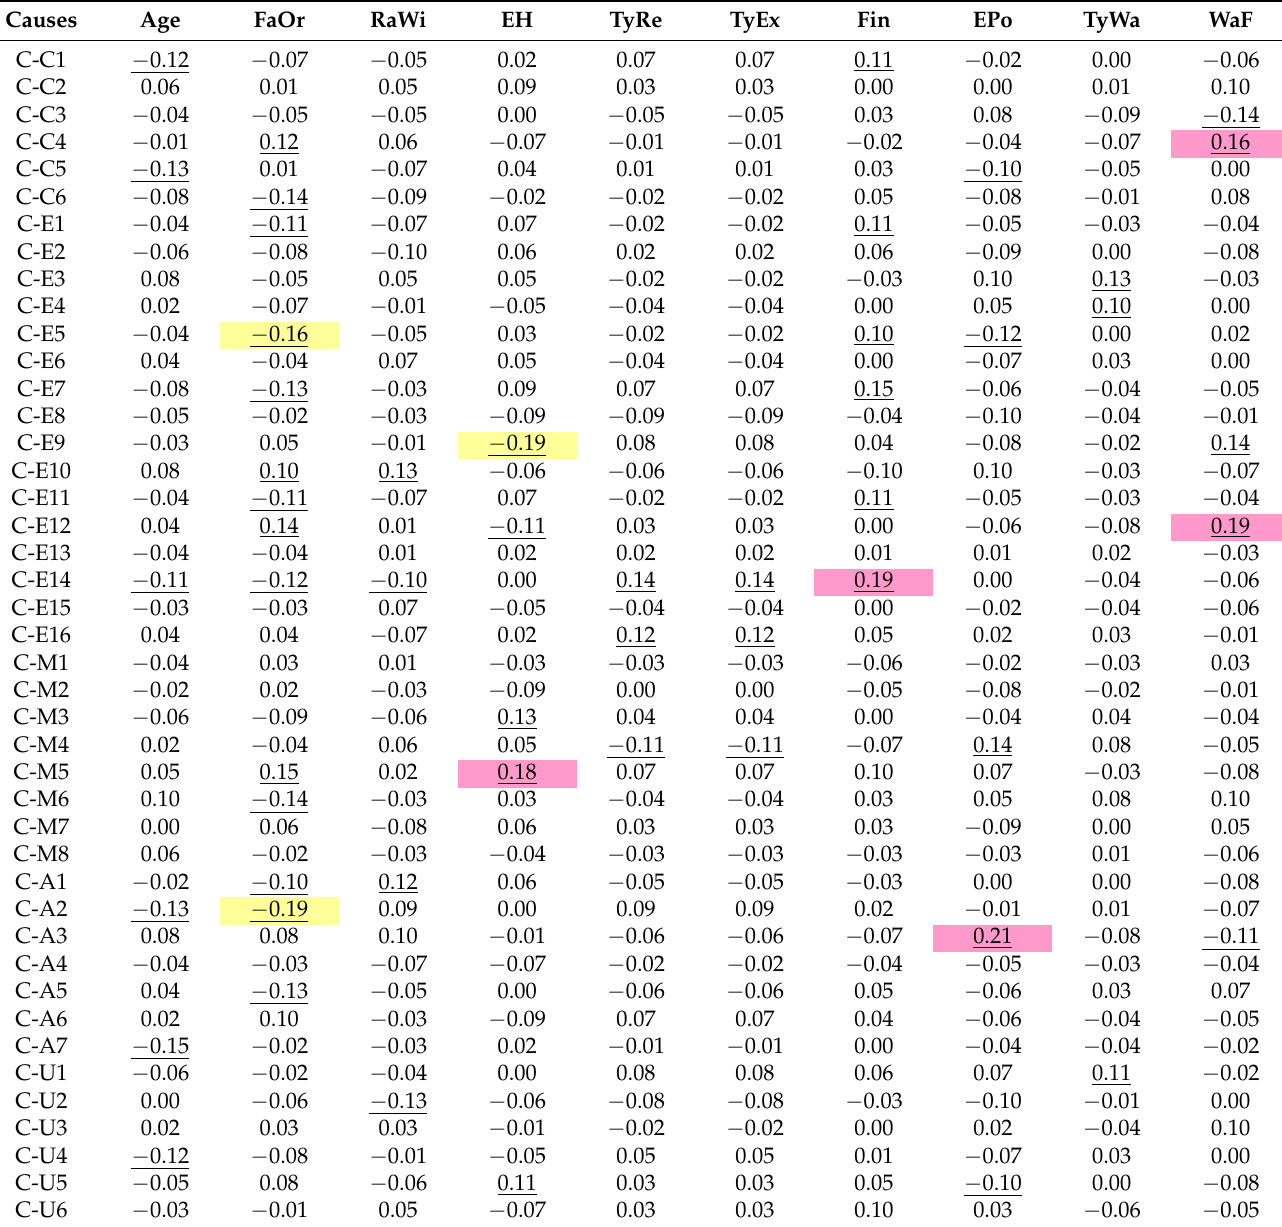
Table 2. Spearman rank-order correlations between causes and characteristics of buildings and